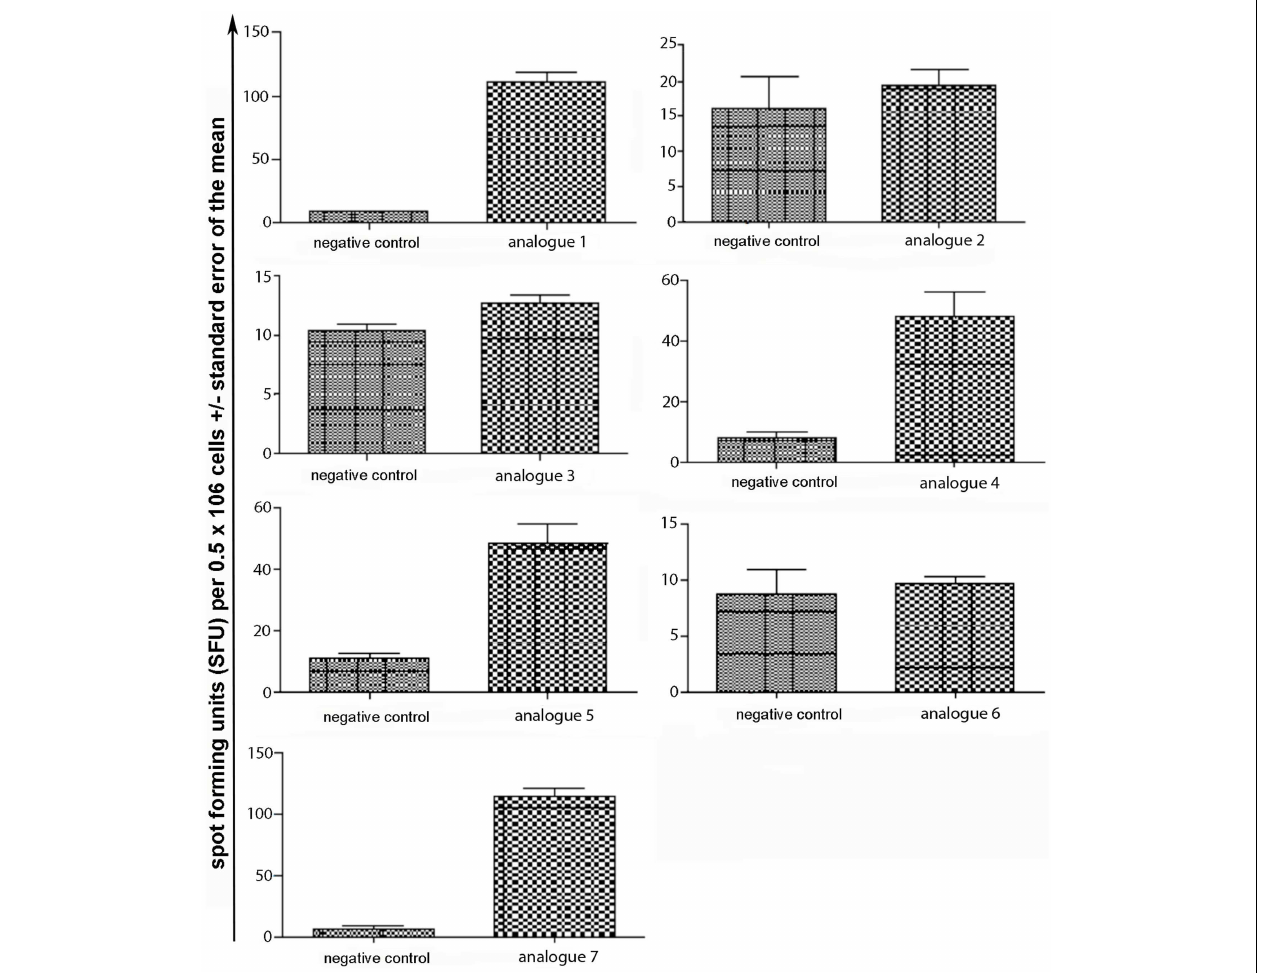
conjugated to reduced mannan via KLH linker (analogs 6 and 7 ). No peptide (cells alone) was used as background negative control. ConA was used as an internal positive control to ensure cells were reactive, not